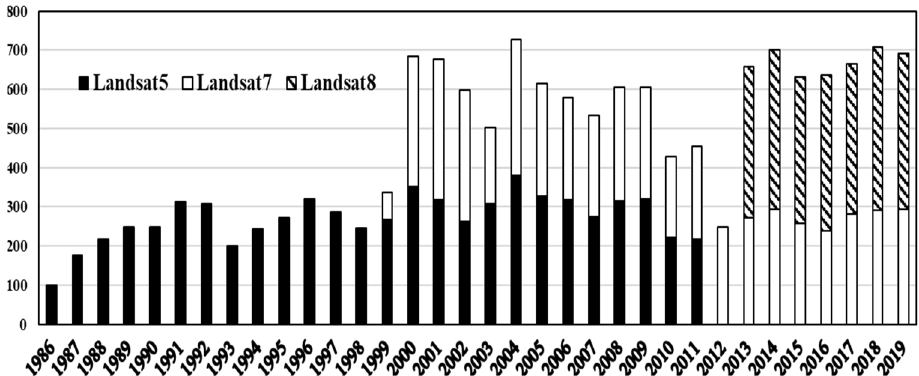
Figure 2. Available image tiles from different Landsat platforms during the growing seasons of 1986–2019 in the study region. Table 1. The sources, categories and numbers of sampling plot data. NFI: national forest resource inventory; LFMI: local forest management